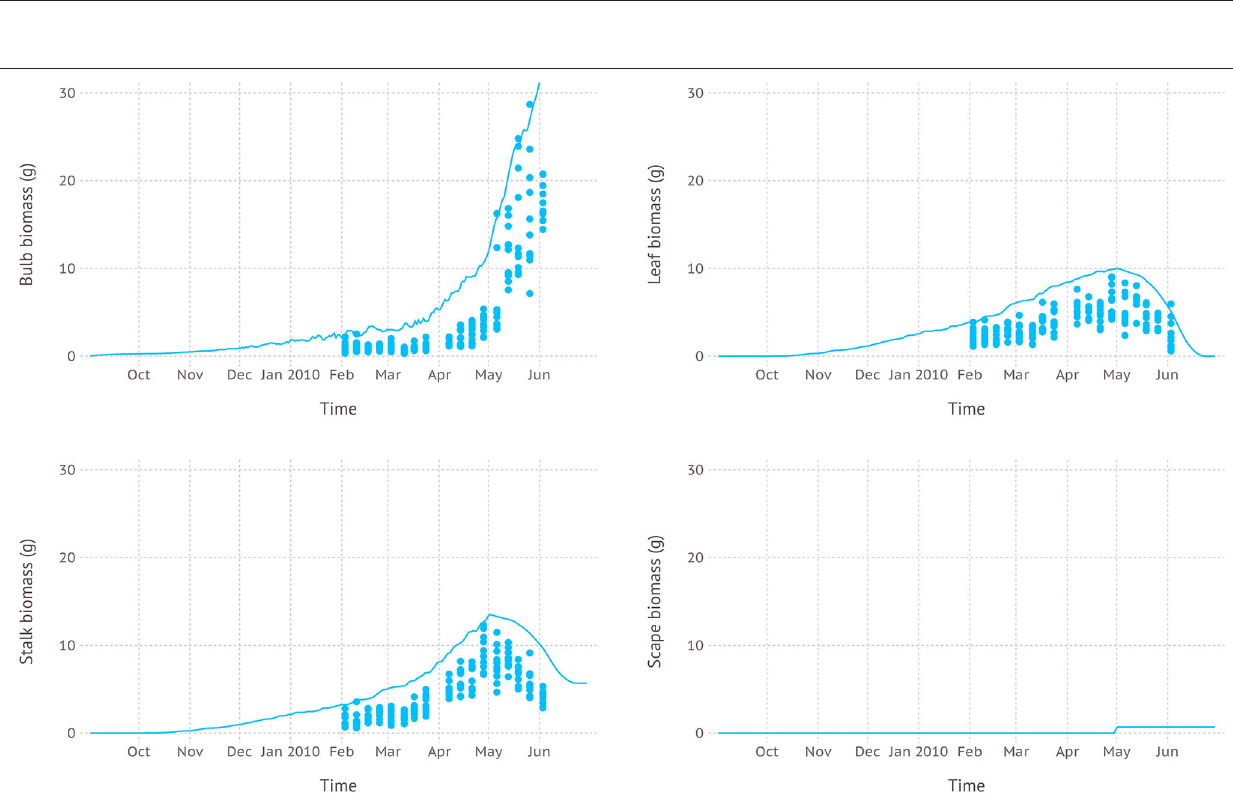
Frontiers in Plant Science |